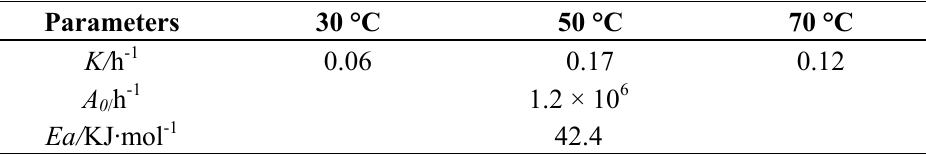
Table 5. Kinetics and Arrhenius parameters for the decrystallization of MCC with phosphoric acid. Parameters